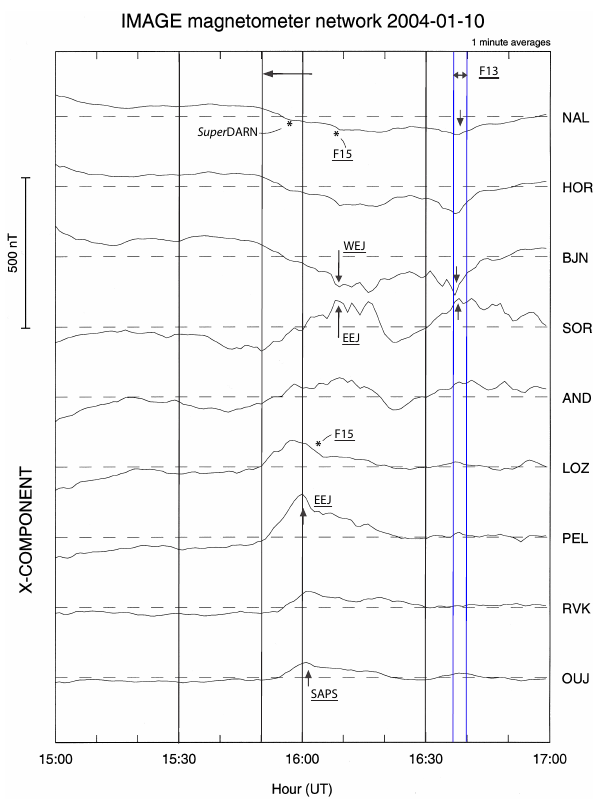
Fig. 5. The X-component of the geomagnetic field for the inter- val 15:00–17:00UT from ground stations of the IMAGE chain in Svalbard – Scandinavia – Russia. The station acronyms are marked on the right side. Deflection maxima relating to EEJ (16:00, 16:09 and 16:38UT) and WEJ (16:09, 16:37UT) activities are indicated by arrows. Near perfect conjunctions of satellite F15 and ground stations LOZ (16:04UT) and NAL (16:08UT) have been marked by starred symbols along the respective traces. The interval of en- hanced antisunward flow in the polar cap detected by F13 in the interval 16:37–16:40UT is marked by vertical lines.